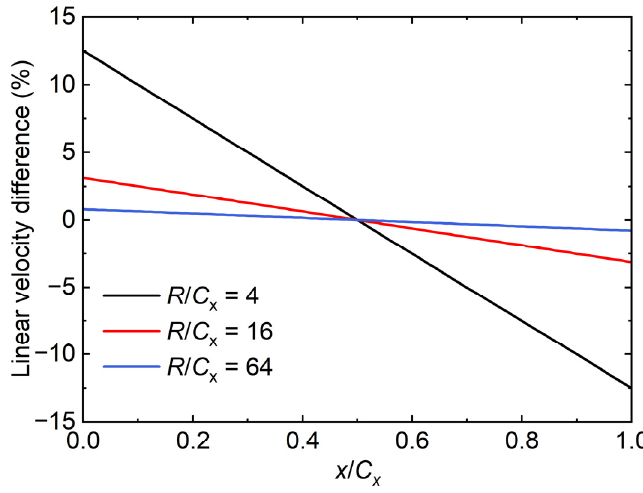
Figure 3. Evaluation of linear velocity difference.